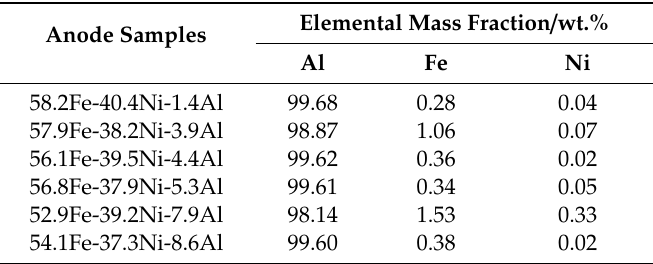
Table 1. The purity of aluminum obtained by inert anode electrolysis at 850 °C. Elemental Mass Fraction/wt.% Anode Samples